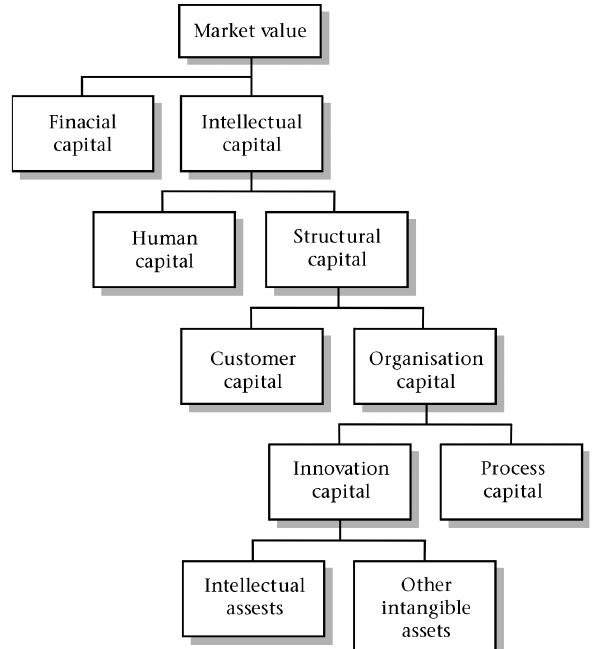
Figure 1: IC Determinants A model based on the previous discussion is indicated in Figure 2.